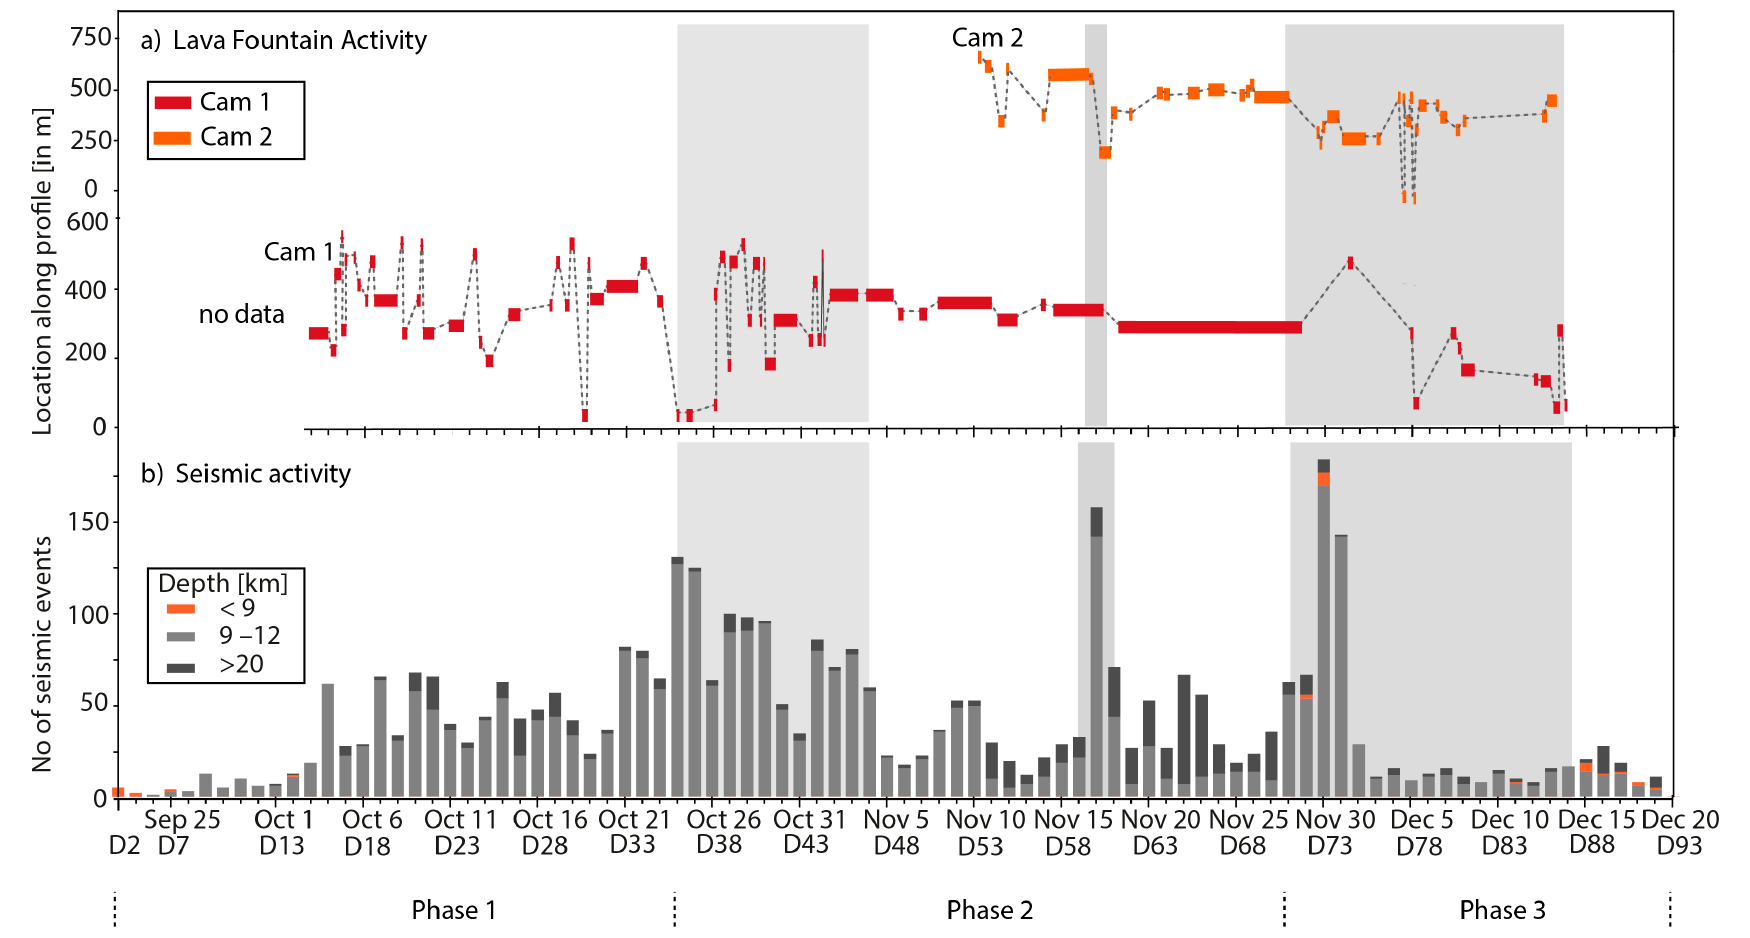
Figure 6. Data time series comparing kymograph results of inferred lava fountain activity (top) and seismic data (bottom) as a function of time (shown as month–day, and as the day of the eruption (D). ( a ) Lava fountain activity extracted from the peaks on the intensity of the kymographs of Camera 1 (Cam 1) and Camera 2 (Cam 2). The red and orange line shows the track of the intensity peaks extracted from the kymographs, dashed black line is interpolated and shows periods of no visibility. ( b ) Seismic data plotted by the number of daily seismic events and classified by depth. The shallow depths are highlighted by orange color. The gray background indicates periods where we can infer a relationship between the seismic events and the lava fountain activity.